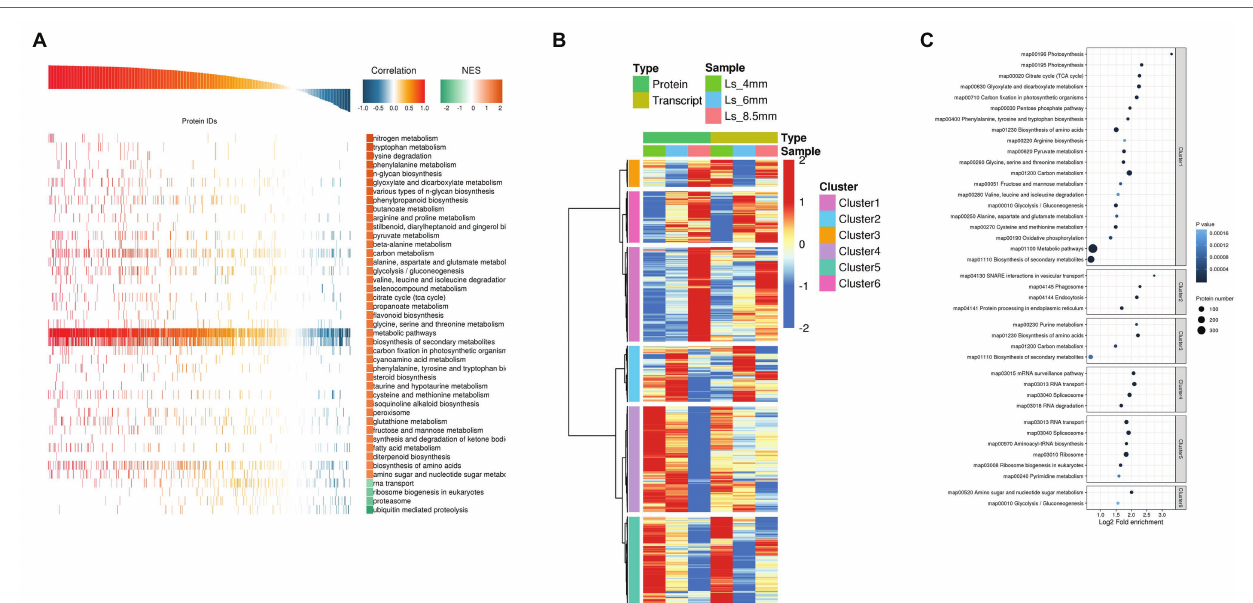
FIGURE 6 | Correlation analysis of transcriptome and proteome data from O. longistaminata anthers of different spikelet growth stages. (A) Protein and transcript GEST analysis. Pathways with NOM p < 0.05 were used to draw a GSEA analysis chart. Correlation is close to 1.0, indicating a positive correlation between gene translation and protein translation. Correlation is close to − 1.0, indicating a negative correlation. The reliability of Kyoto Encyclopedia of Genes and Genomes (KEGG) enrichment results was high when NES was close to 2, and low when NES was close to − 2. (B) Cluster analysis of combined protein and transcriptome data. Expression values were log2-transformed, and the mean value was subtracted; then the Hclust “Ward.D” method was used for cluster analysis. (C) KEGG enrichment analysis was performed for each protein class by Fisher’s exact test method, and the enrichment results for different classifications were combined. Then, the top 40 ( p < 0.05) significantly enriched functional classifications were identified. The horizontal axis shows fold enrichment after Log2 transformation, the vertical axis shows the functional classification, the bubble size represents the number of proteins, and the bubble color represents the value of p of enrichment